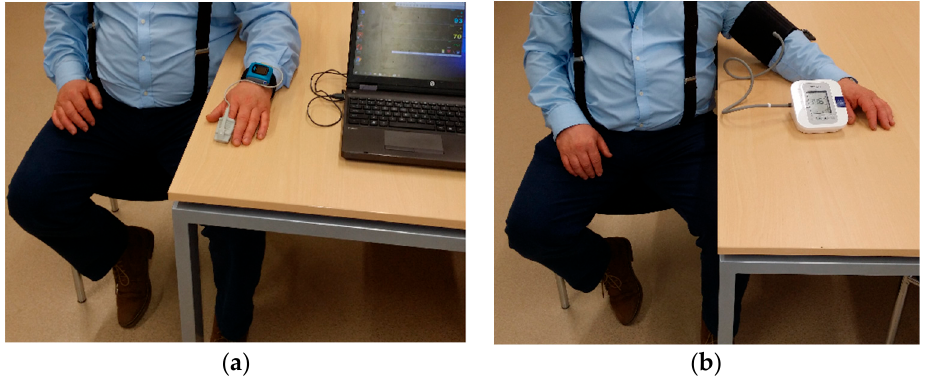
Figure 14. ( a ) PPG signal recording posture; ( b ) SBP measurements posture.